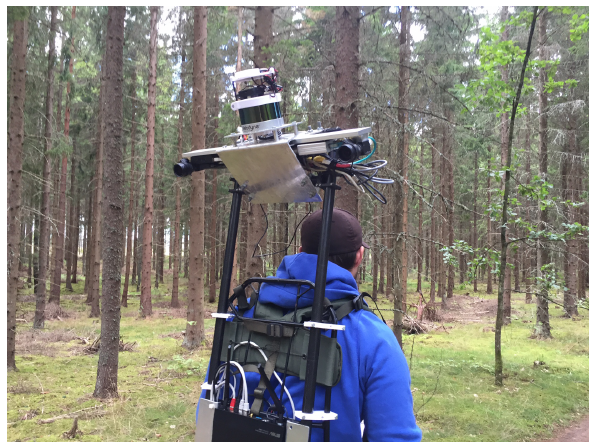
Figure 1. Experimental MLS system.